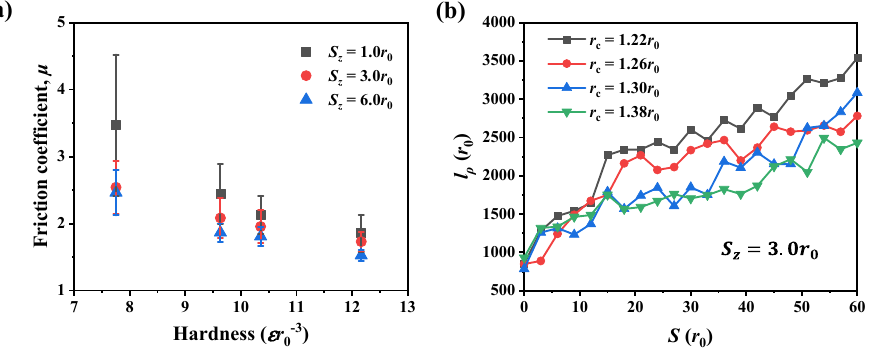
Figure 8. ( a ) Frictional coefficient in materials of different hardness. ( b ) Evolution of dislocation length in four materials as the scratching advances.